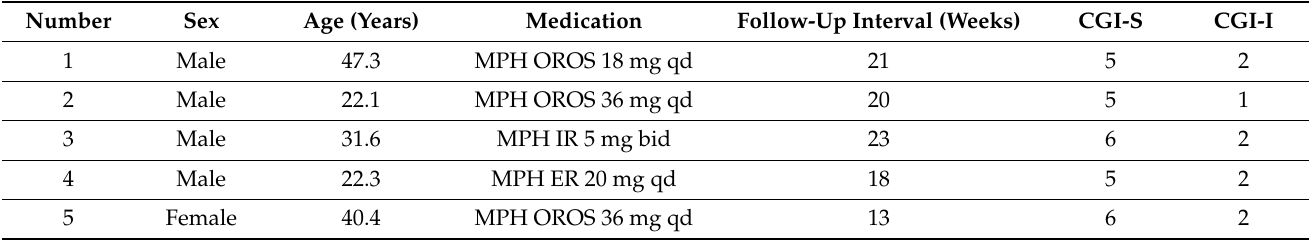
Table 2. List of subjects examined before and after the methylphenidate treatment.